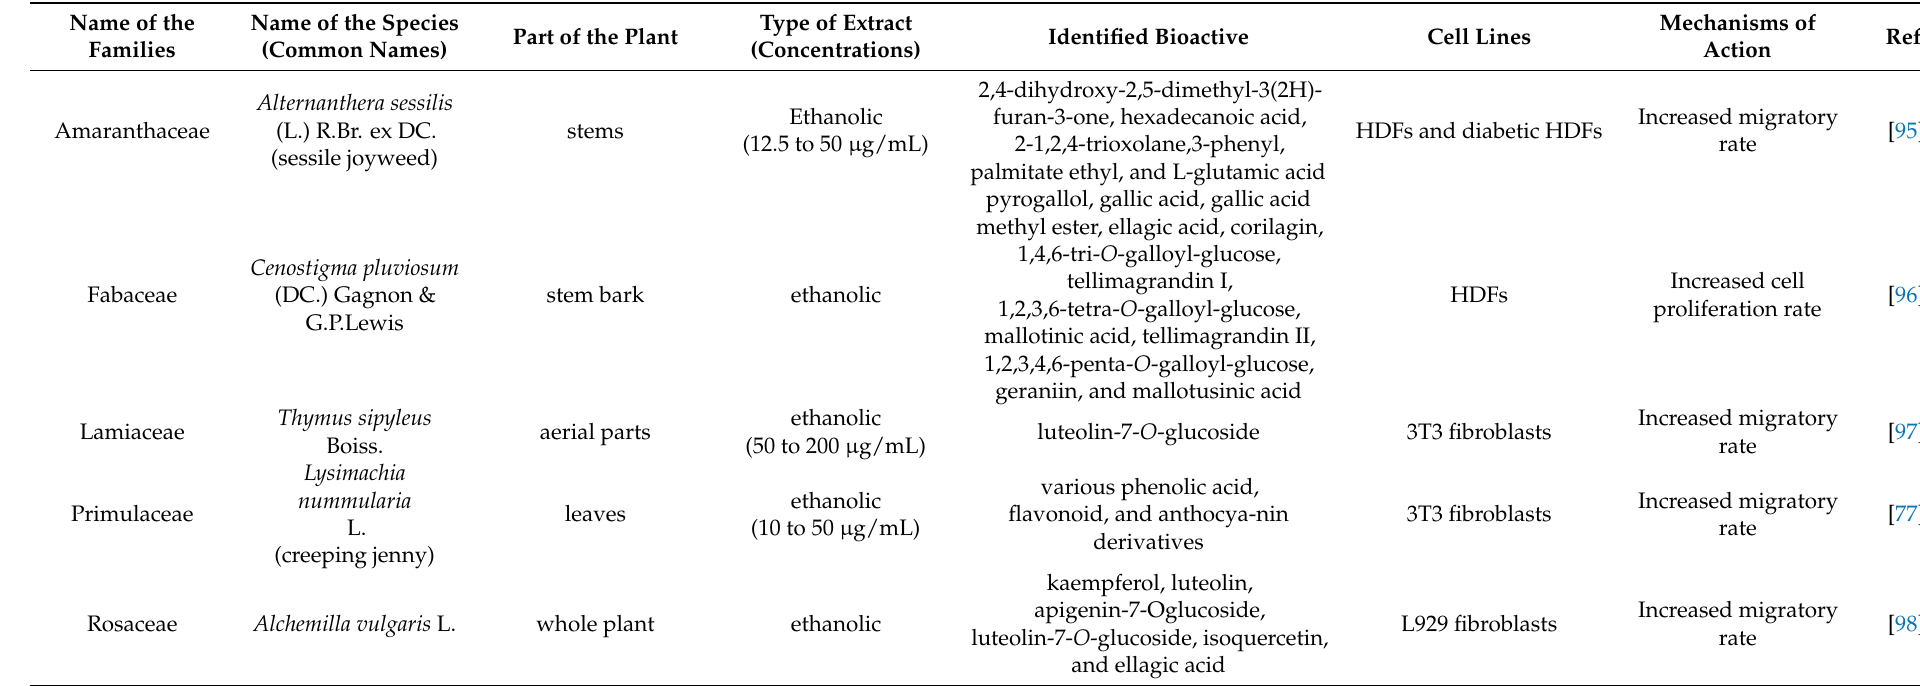
Table 2. Selected plant extracts from different species with identified phenolic compounds and their in vitro effect on dermal fibroblast cells and migration